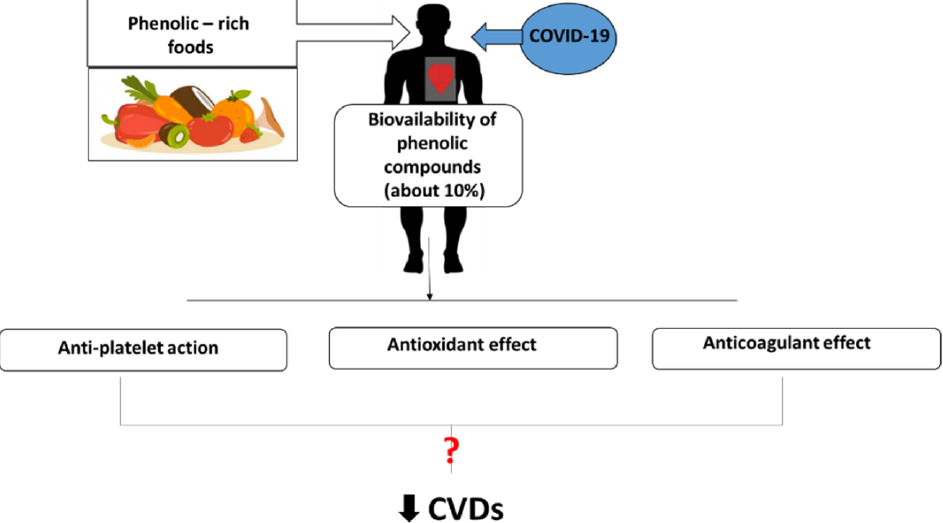
Figure 1. The relationships between dietary phenolic compounds with antiviral potential and CVDs, and their presumed role in protecting against CVDs in patients with